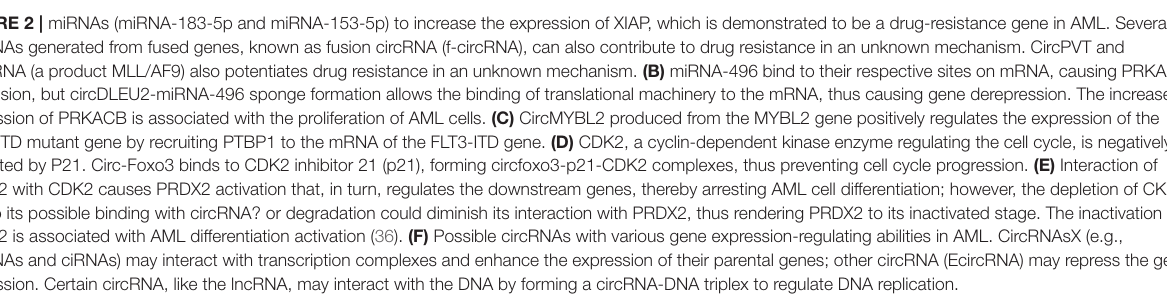
FIGURE 2 | miRNAs (miRNA-183-5p and miRNA-153-5p) to increase the expression of XIAP, which is demonstrated to be a drug-resistance gene in AML. Several circRNAs generated from fused genes, known as fusion circRNA (f-circRNA), can also contribute to drug resistance in an unknown mechanism. CircPVT and f-circRNA (a product MLL/AF9) also potentiates drug resistance in an unknown mechanism. (B) miRNA-496 bind to their respective sites on mRNA, causing PRKACB repression, but circDLEU2-miRNA-496 sponge formation allows the binding of translational machinery to the mRNA, thus causing gene derepression. The